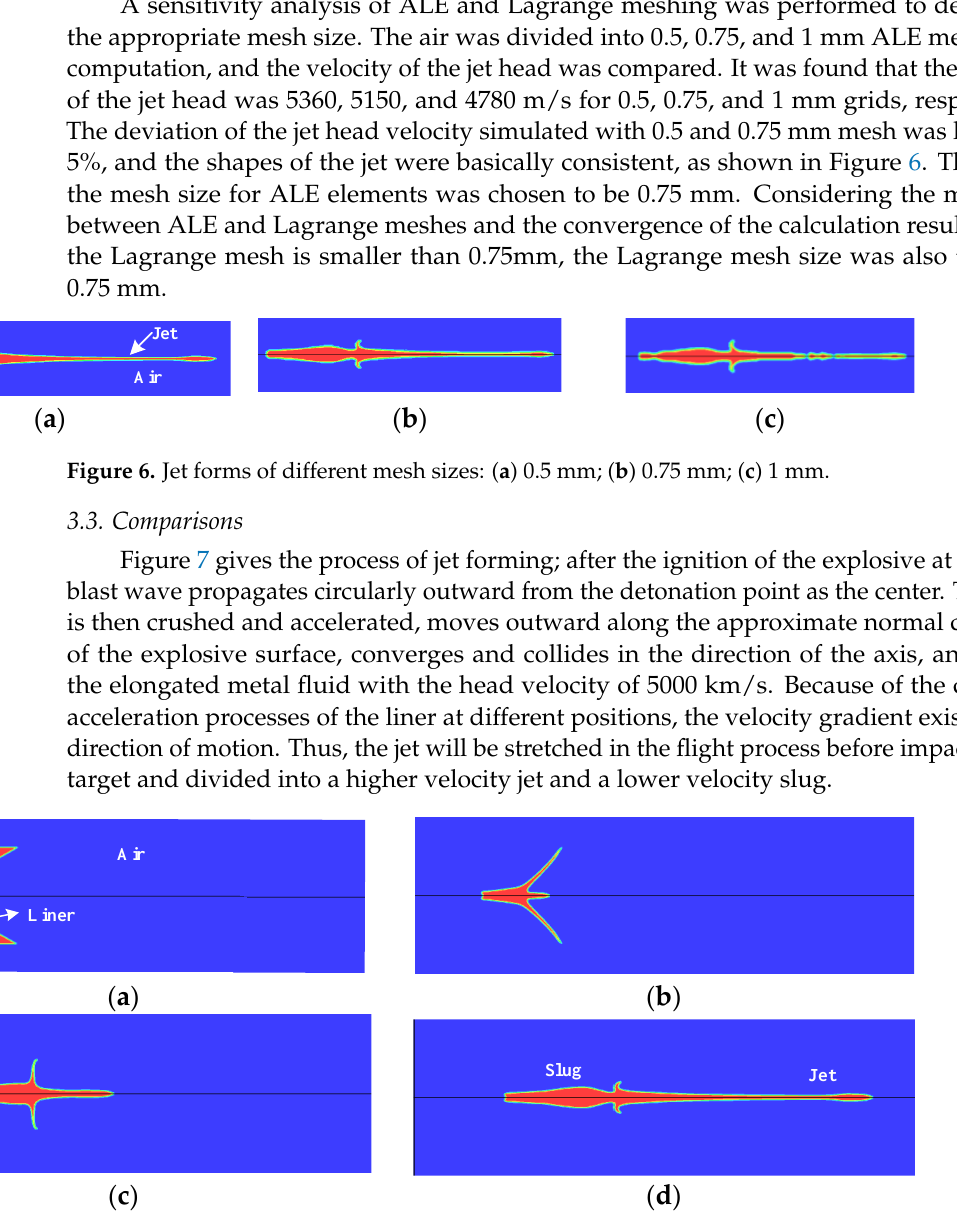
Figure 7. Jet formation process: ( a ) 0 μs; ( b ) 10 μs; ( c ) 20 μs; ( d ) 40 μs.